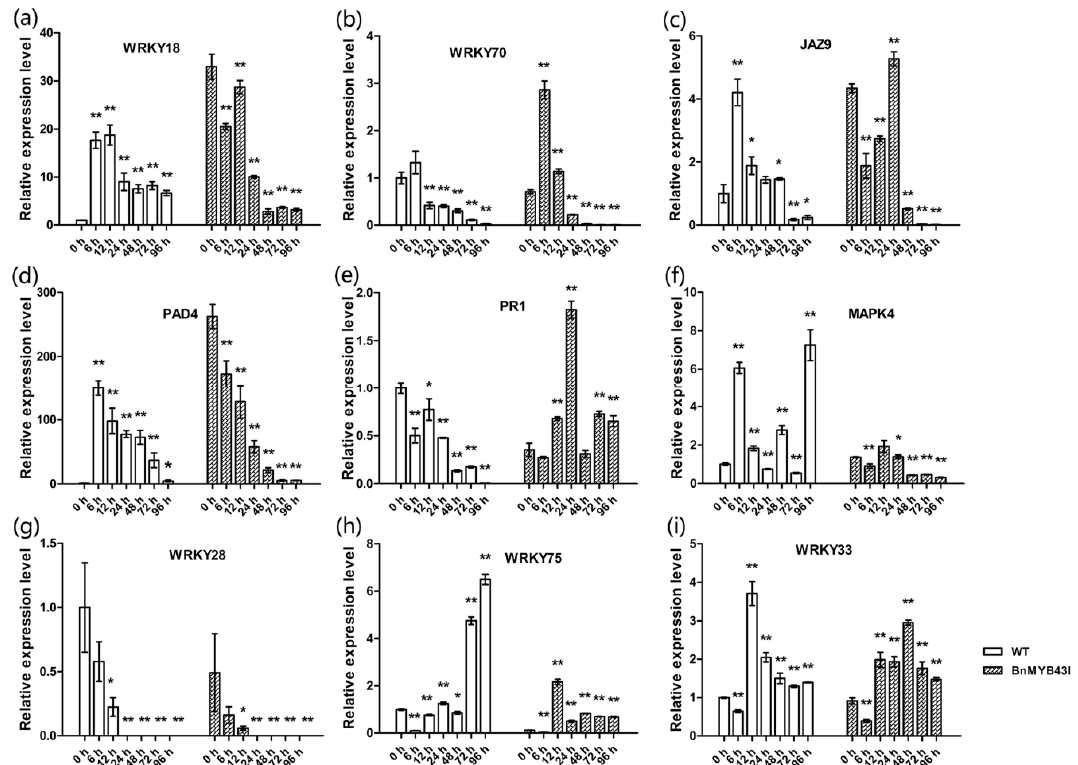
Figure 7. The expression patterns of genes related to plant–pathogen interactions in the plants after silencing BnMYB43 gene family. ( a–c ) The expression of genes related to salicylic acid or jasmonic acid signal pathways. ( d,e ) The expression of other genes related to plant defense. ( f–i ) The expression of genes related to S. sclerotiorum susceptibility or resistance in B. napus . Expression level of each gene in WT was set as 1. Expression level of 25SrRNA was used as control reference. Values are means ± SD ( n = 3 biological replicates). Asterisks indicate significant or extremely significant differences from the control (*, 0.01 ≤ p < 0.05; **, p < 0.01) using one-way ANOVA.